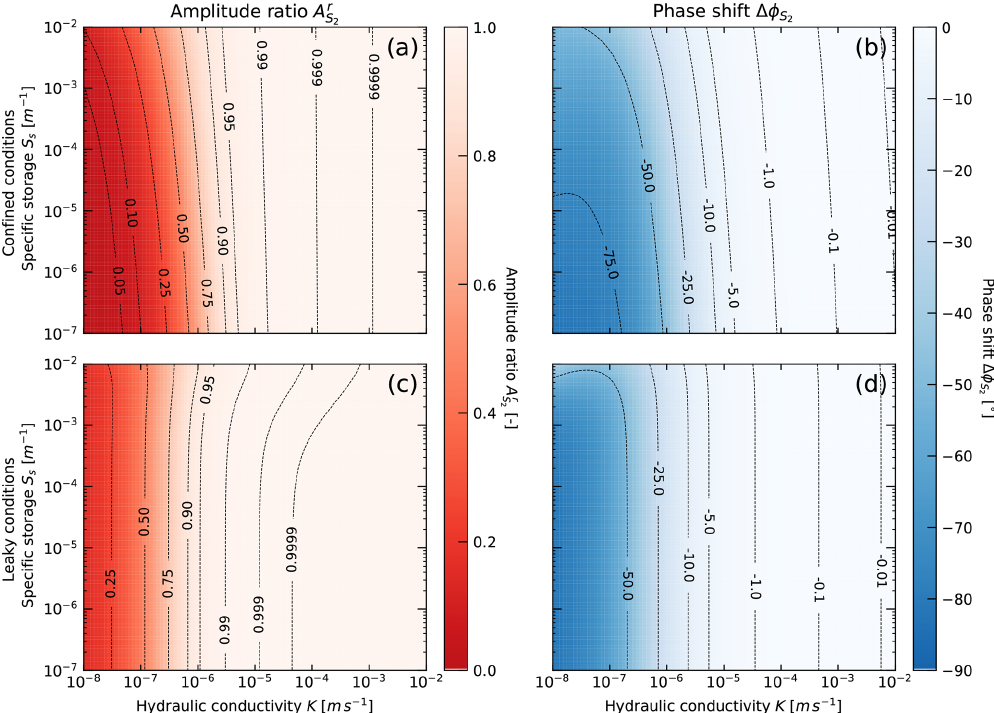
Figure 1. Amplitude ratio and phase shift relationship between subsurface pore pressure and well water level for harmonic forcing under fully confined conditions (a, b) and vertical water leakage under semi-confined conditions (c, d) . The leaky aquitard has K (cid:48) = 5 × 10 − 5 m/s and b (cid:48) = 2m. The plots are calculated for a hypothetical well with radius of 25mm and screen length of 1m and realistic ranges of hydraulic conductivity and specific